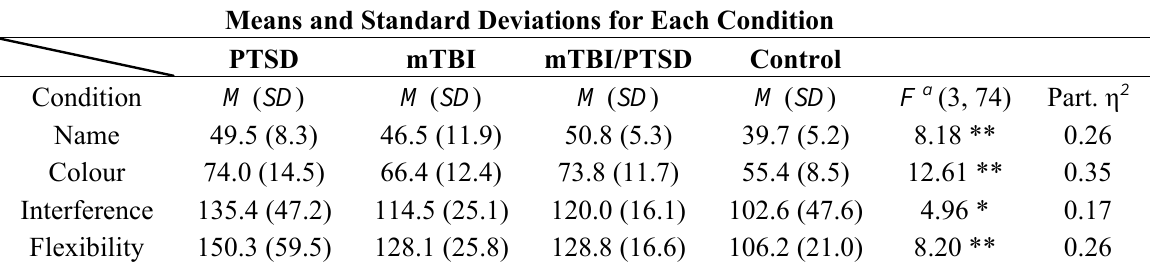
Table 3. Completion Time in Seconds on Stroop Task (Raw